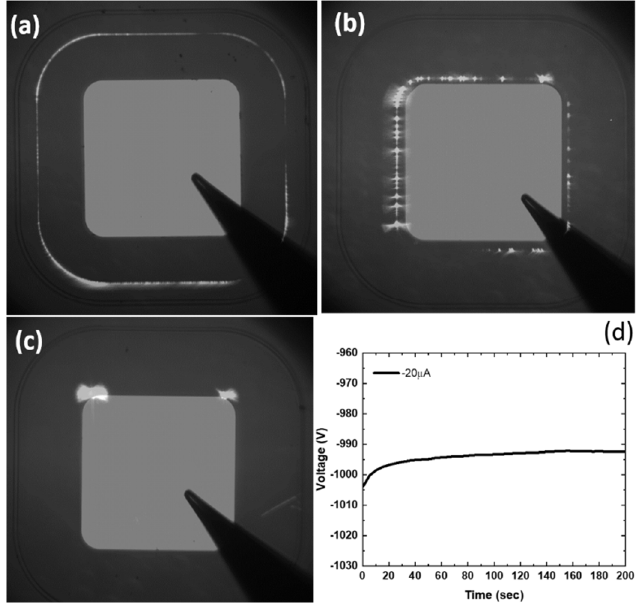
Figure 3. Electroluminescence broadband. ( a ) 500 nm anode; ( b ) 400 nm anode; ( c ) 300 nm anode; ( d ) DC-IV of the -20uA reverse hold.